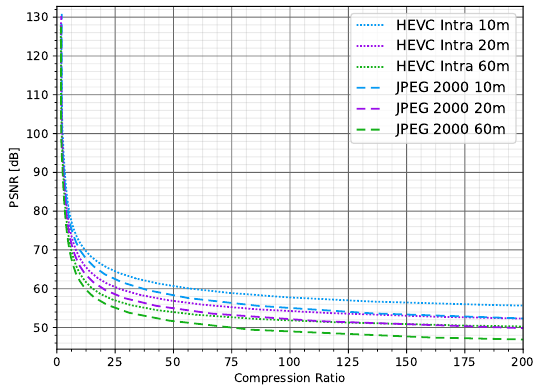
Figure 7. Compression performance comparison over satellite images with different spatial resolutions. Pixel resolutions of 10, 20, and 60 m correspond to channels of Sentinel-2A/B images listed in Table